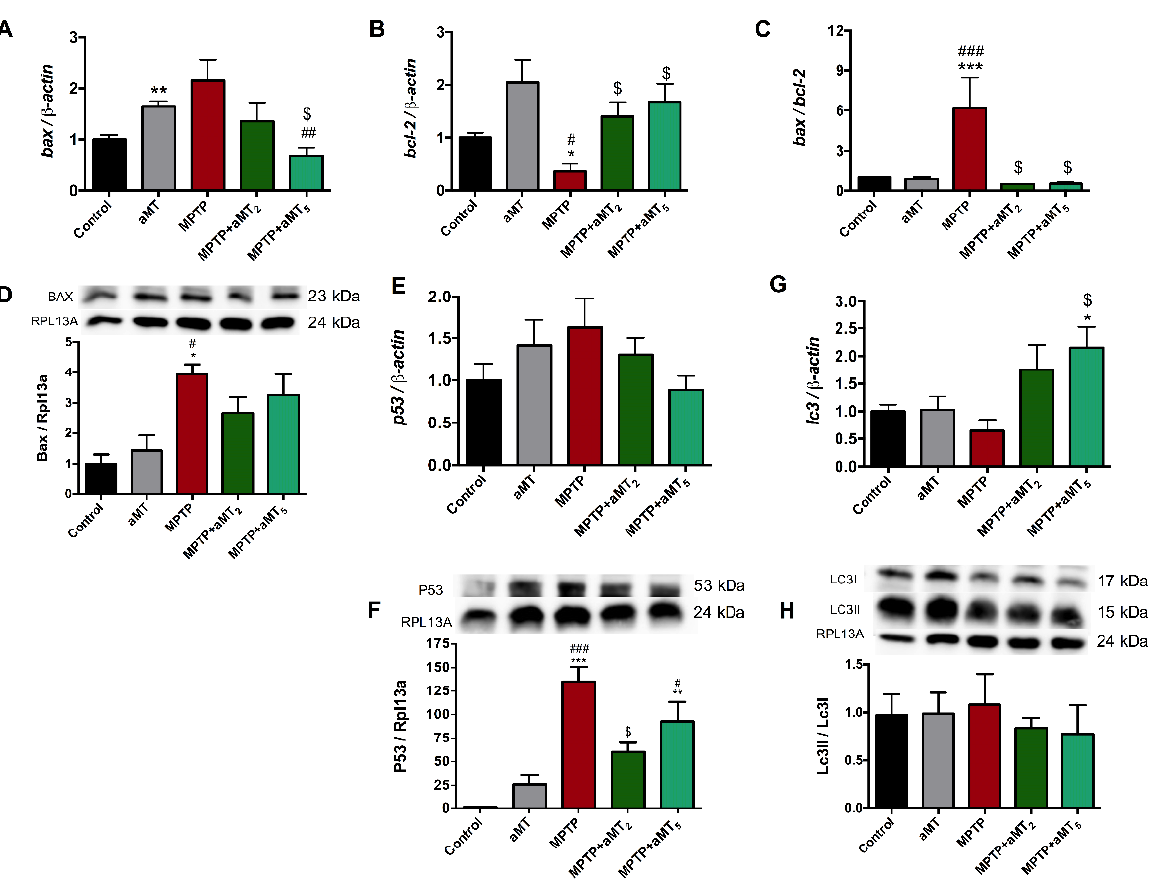
Figure 7. Analysis of apoptotic and autophagy pathways. ( A ) bax and ( B ) bcl-2 mRNA expression in the studied groups, and the bax/bcl-2 ratio ( C ). ( D ) protein levels of Bax. ( E ) p53 mRNA expression and ( F ) P53 protein levels. ( G ) mRNA expression of lc3 and ( H ) protein ratio of Lc3II/Lc3I. Data are presented as mean ± SEM. * p < 0.05 vs. control; ** p < 0.01 vs. control; *** p < 0.001 vs. control; # p < 0.05 vs. aMT; ## p < 0.01 vs. aMT; ### p < 0.001 vs. aMT; $ p < 0.05 vs. MPTP. Unpaired t test and One-way ANOVA with a Tukey’s post hoc test.